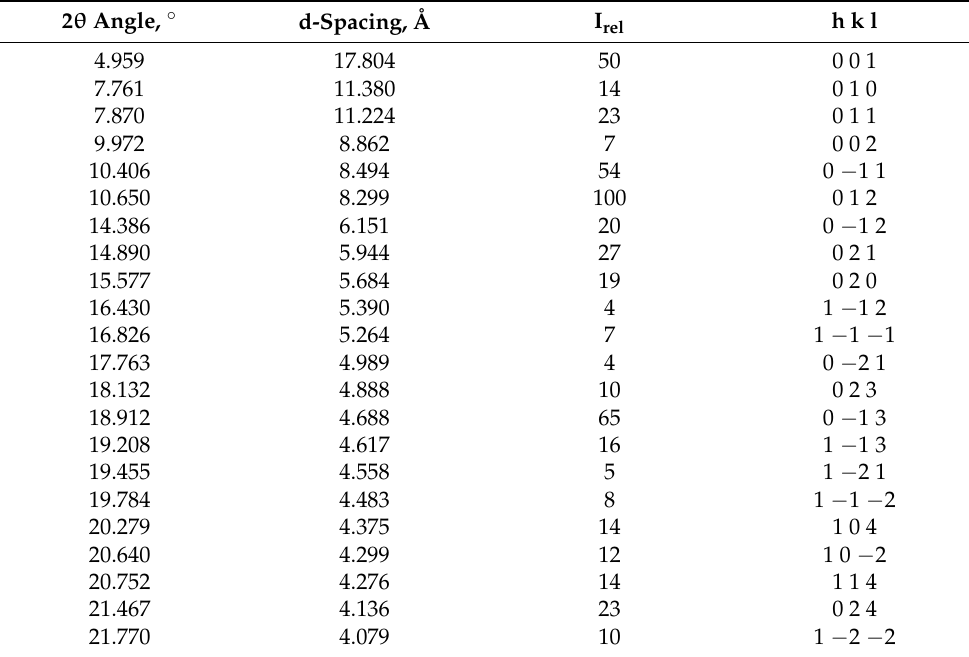
Table 14. List of observed 2 θ angles, d-spacings, and relative intensities, jointly with reflection indices, for Eltrombopag Form XIV.